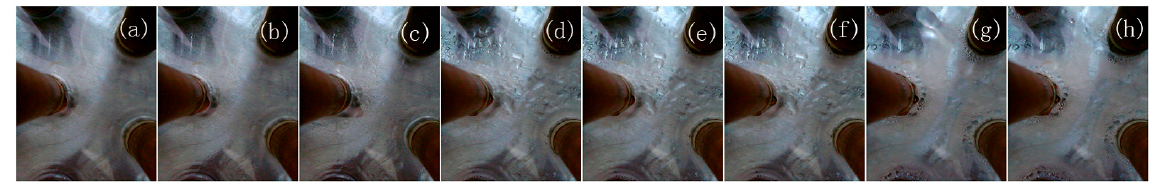
Figure 6. Condensate water on the surface of the aluminum fin with a hydrophilic layer: ( a ) τ = 10 s, ( b ) τ = 60 s, ( c ) τ = 120 s, ( d ) τ = 160 s, ( e ) τ = 200 s, ( f ) τ = 230 s, ( g ) τ = 260 s, ( h ) τ = 290 s.